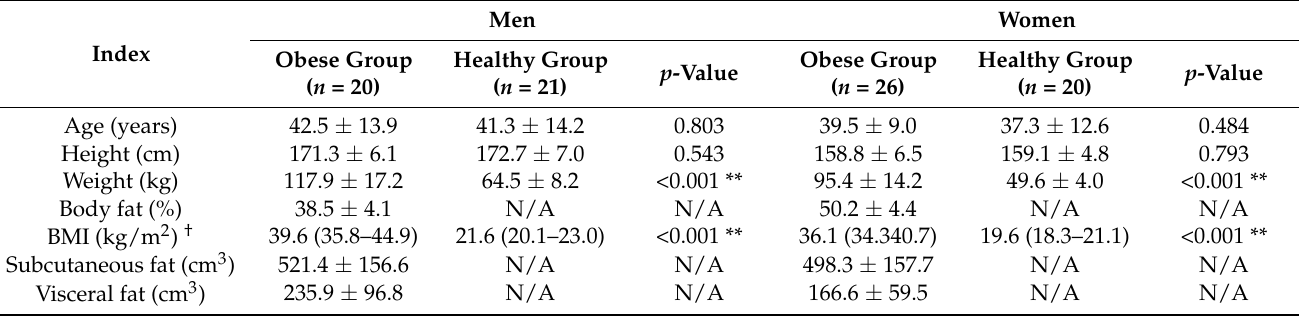
Table 1. Participant